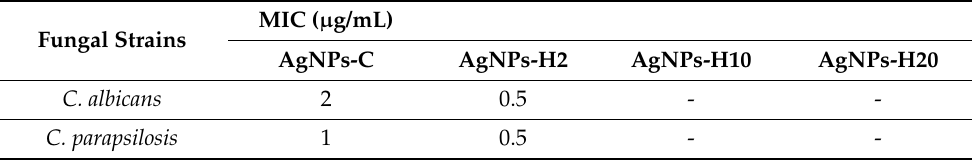
Table 2. Minimal inhibitory concentrations (MICs) of silver nanoparticles (AgNPs) against Can- dida strains.